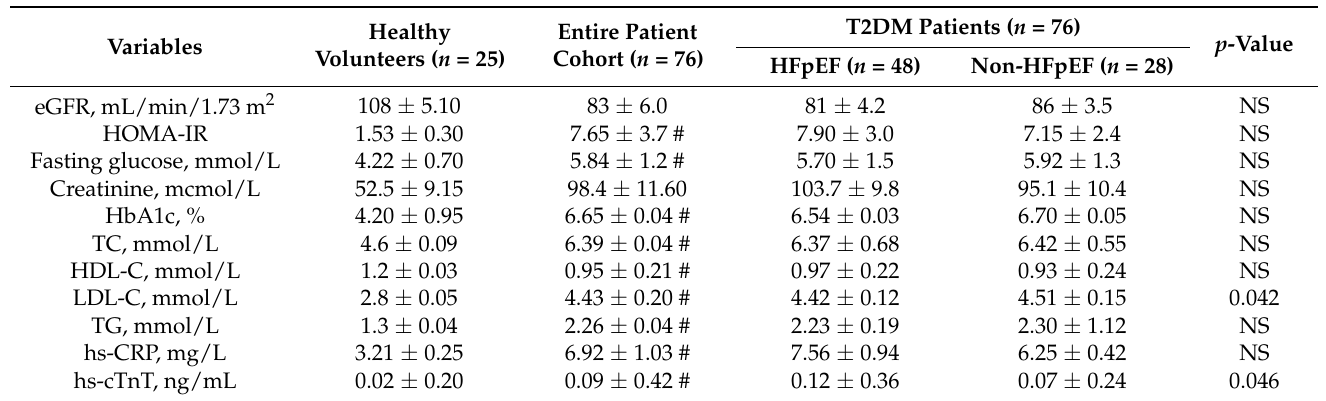
Table 2. Biomarkers in individuals enrolled in the study.